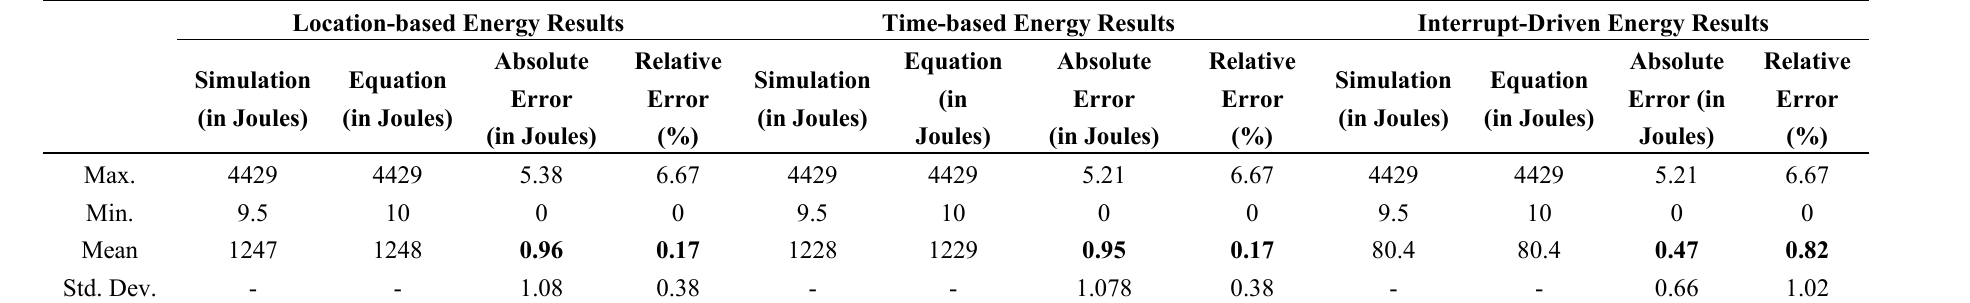
Table 5. Comparison of the energy results as obtained by simulation and the proposed equation.